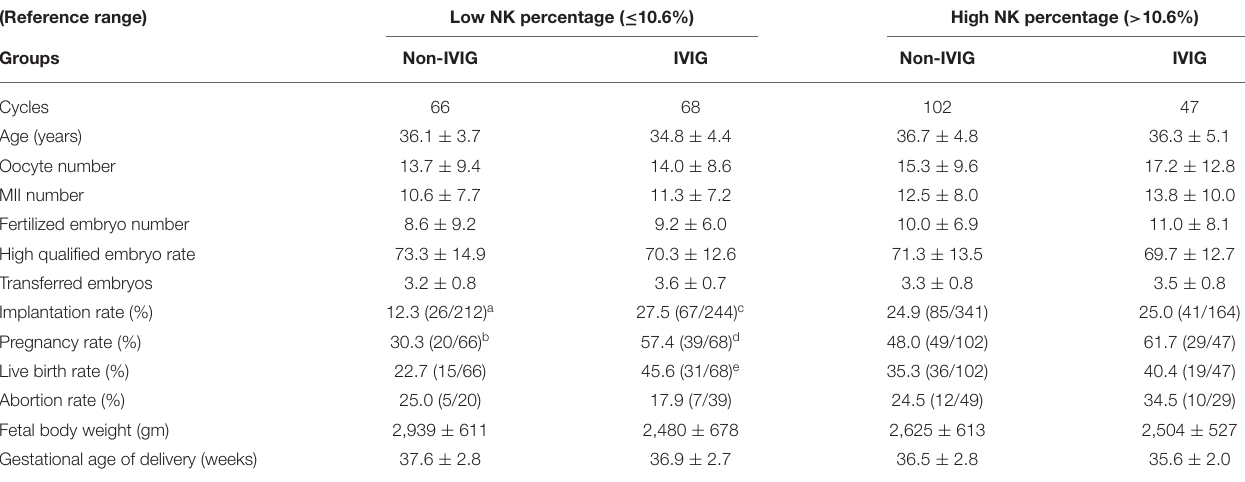
TABLE 3 | Comparison of pregnancy outcomes of IVIG treatment between low and high NK cell percentages. (Reference